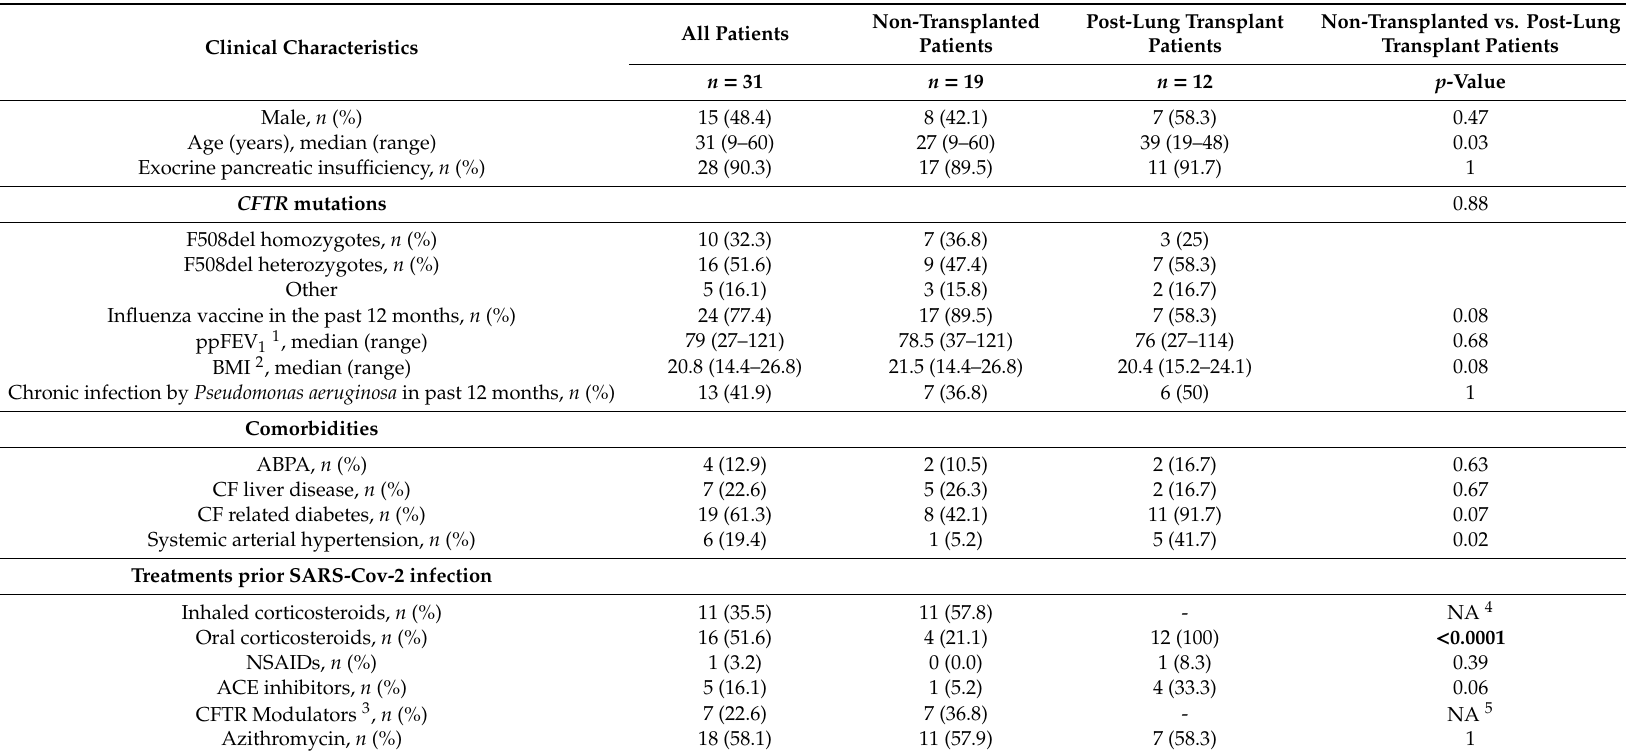
Non-Transplanted Post-Lung Transplant All Patients Patients